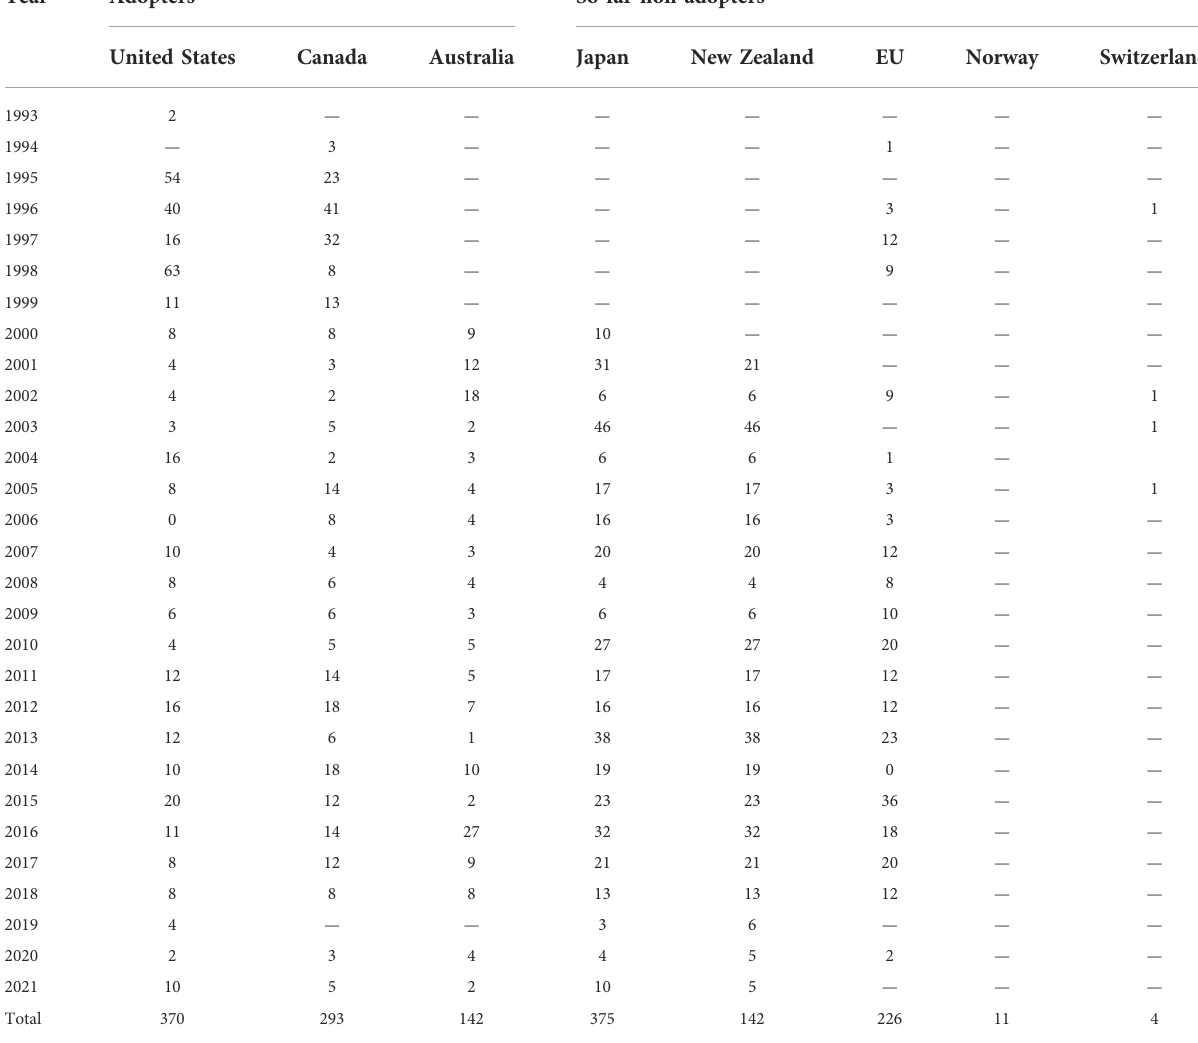
TABLE 3 Number of GM plant events authorised for food and/or feed a use per year per jurisdictions. Source: ISAAA (2021). Year Adopters b So-far non-adopters